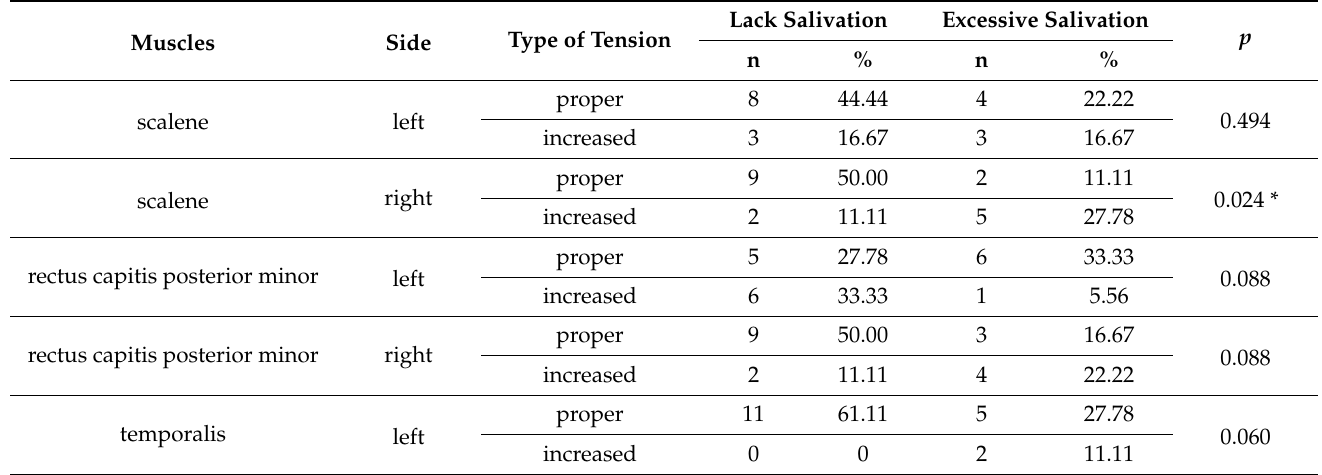
Table 3. The evaluation of dependence between the muscle tension and the occurrence of salivation after therapy (n =